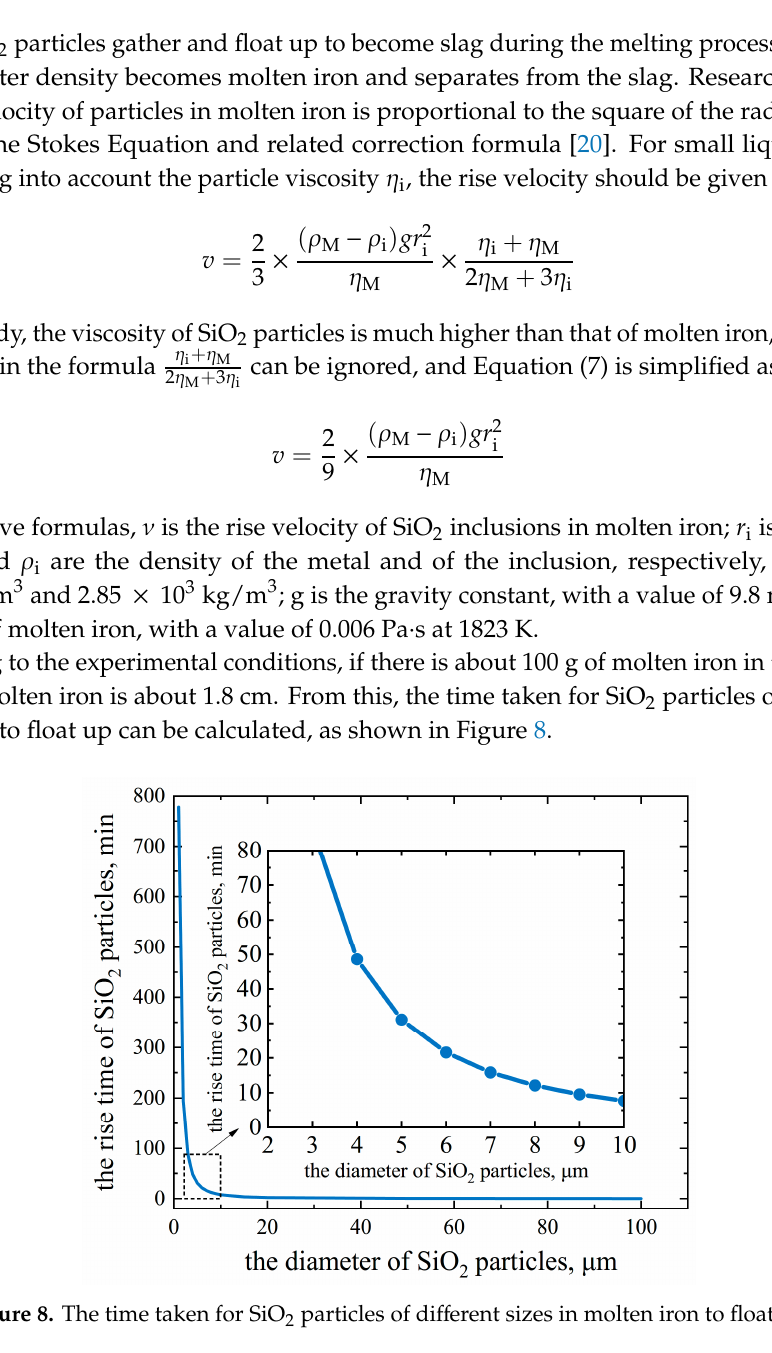
Table 4. The composition and characteristic of slag used for deoxidation.